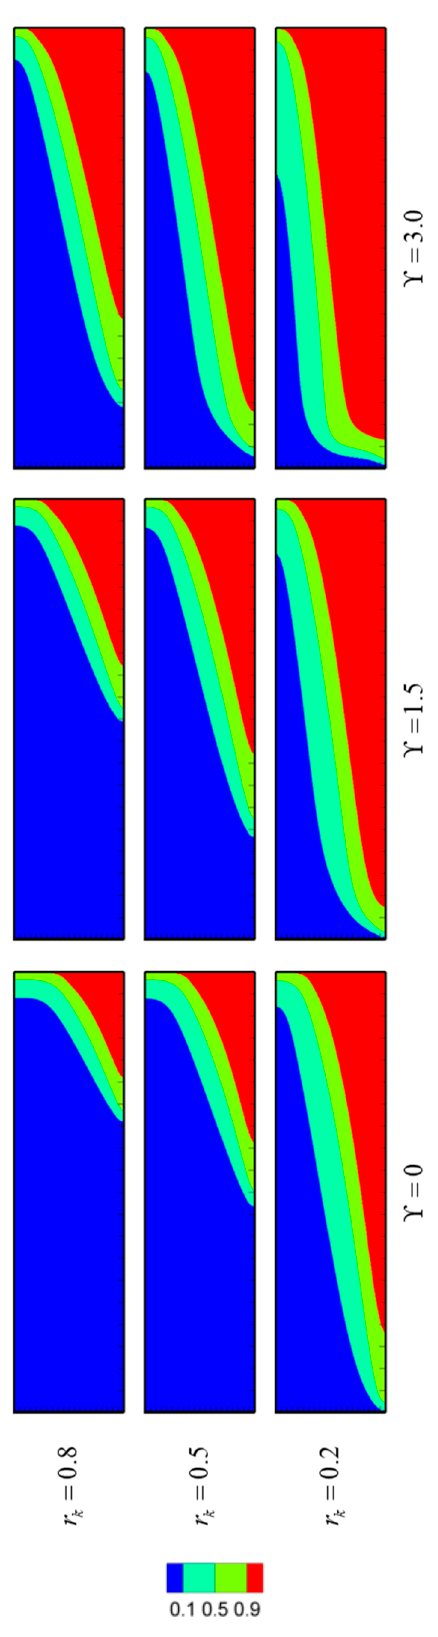
Figure 9. Coupled influence of anisotropy and heterogeneity on the main isochlors (10%, 50%, 90%). Results obtained for a fixed large-scale gravity number NG = 3.11. All other parameters are similar to the dispersive case in Table 1.